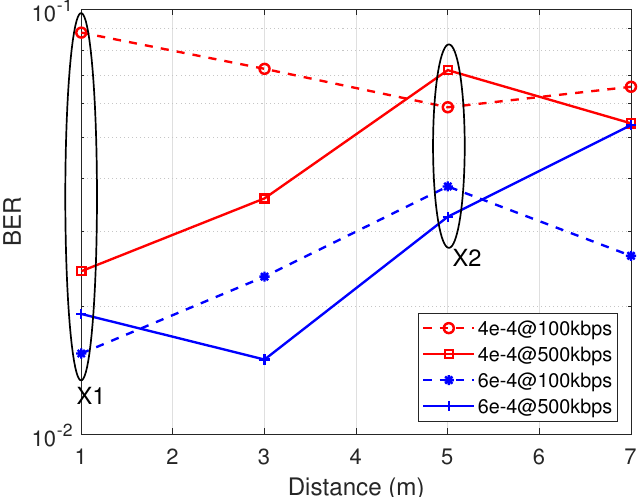
Figure 3. Fixed threshold instability with minimal